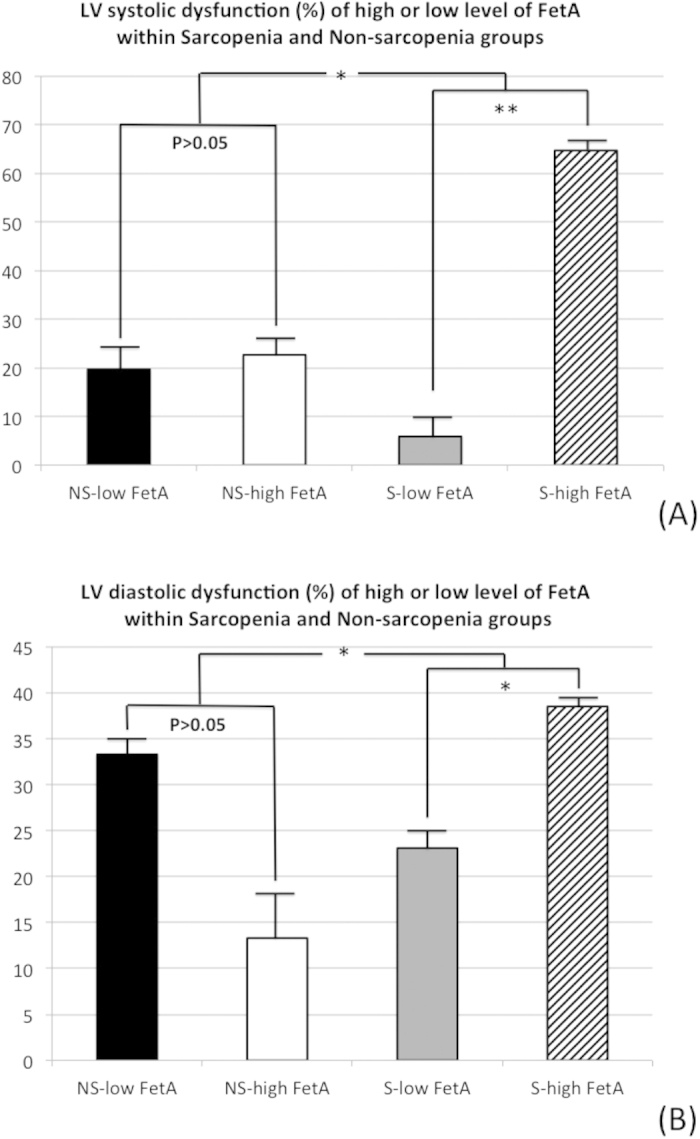
The percentages of left ventricular systolic and diastolic dysfunction were significantly higher in sarcopenic elders with higher fetuin-A (FetA) level.(A) left ventricular (LV) systolic impairment and (B) LV diastolic dysfunction in the non-sarcopenia and sarcopenia sub-populations according to the higher and lower FetA level. Lower FetA: FetA below the 1st quartile; higher FetA: FetA above the 3rd quartile; LV systolic dysfunction: left ventricular ejection faction (LVEF) <50%; LV diastolic dysfunction: coexistence of impaired relaxation (Ea < 8 cm/s by tissue Doppler) and elevated left ventricular end-diastolic pressure (E/Ea > 8) from echocardiography. *p < 0.001; **p < 0.01.